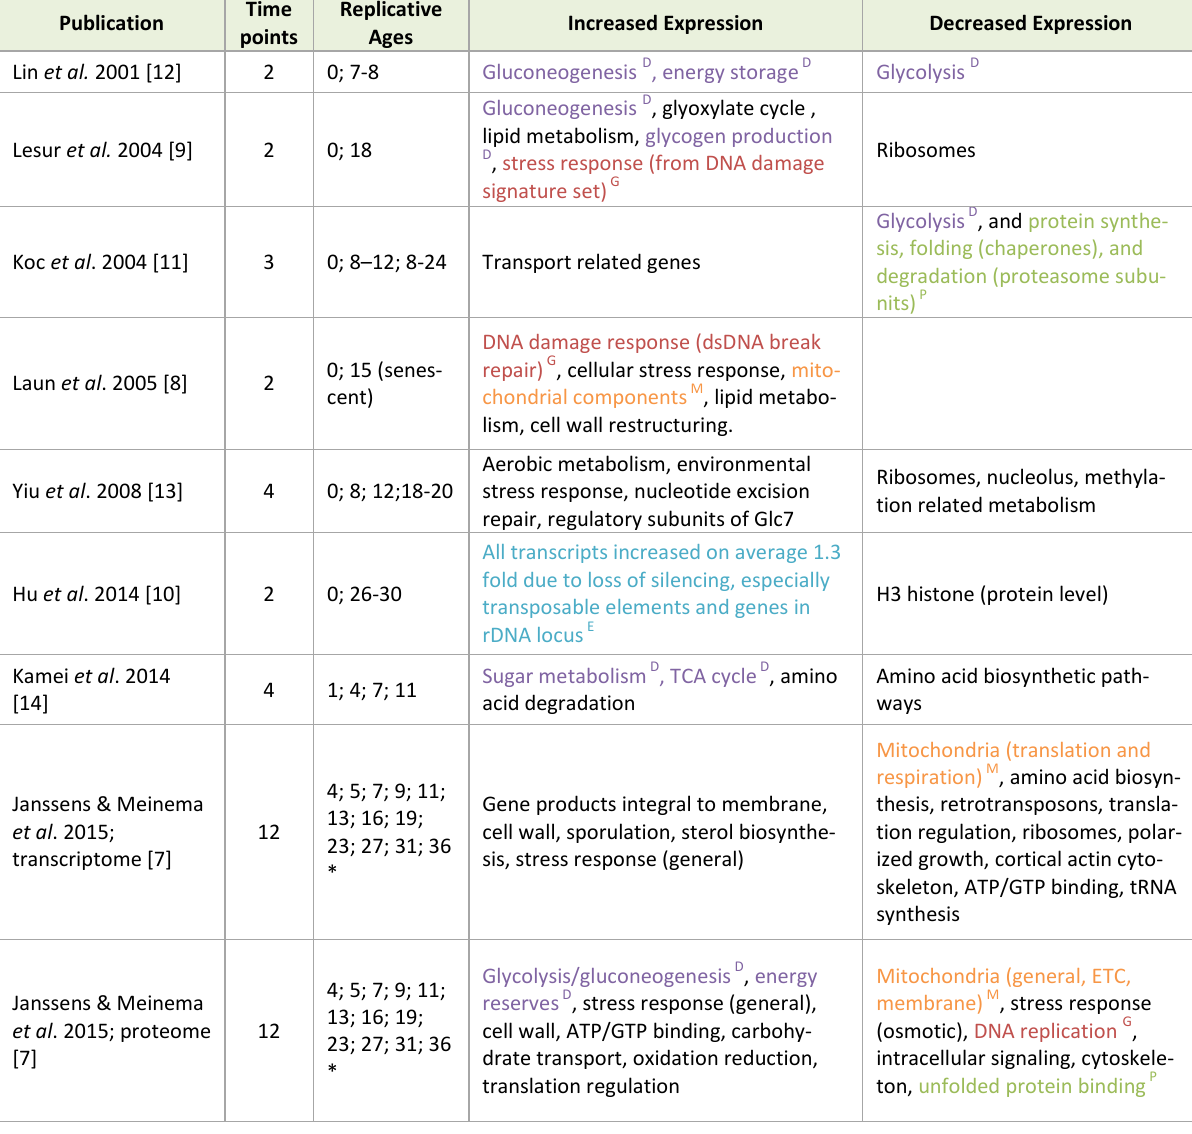
TABLE 1. Overview of system wide gene expression studies in replicatively aging